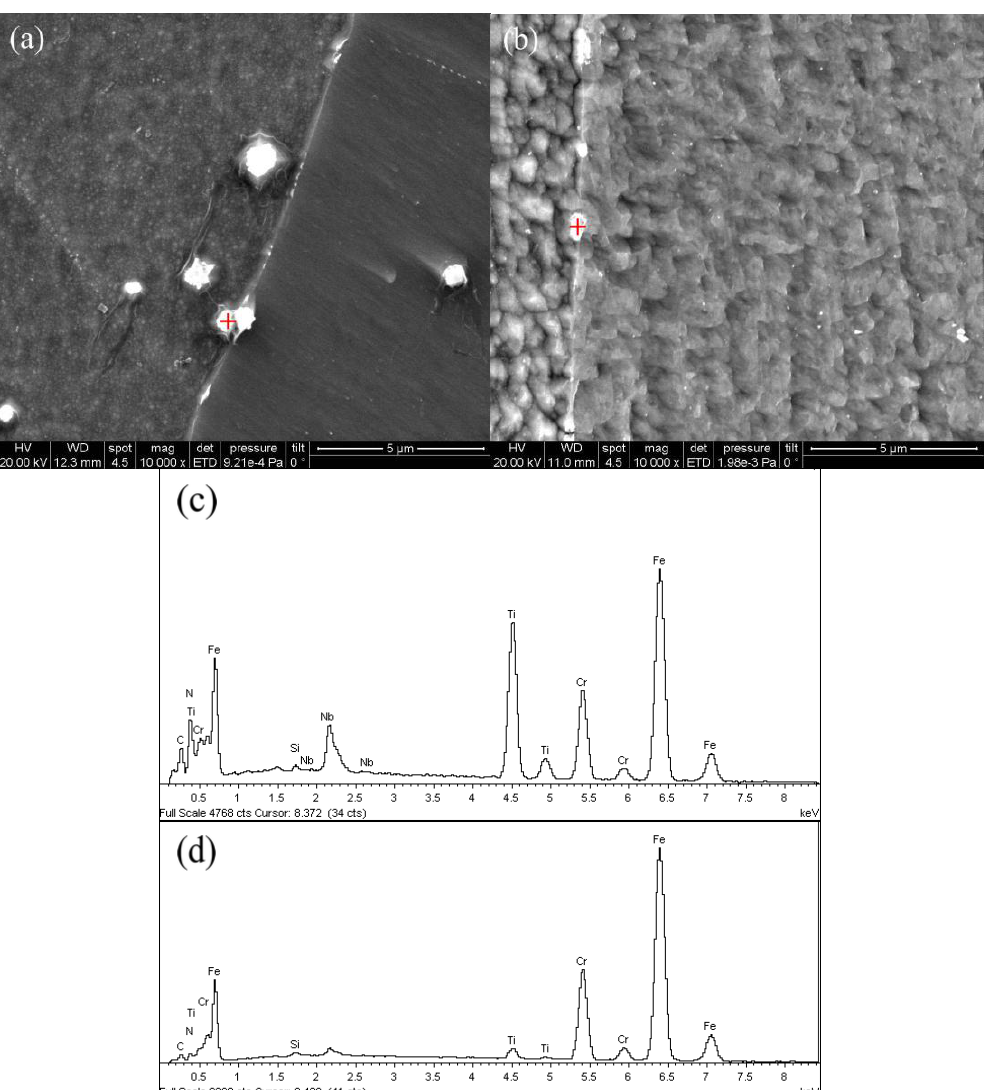
Figure 6. SEM images and EDS analyses of precipitations on the grain boundaries of ( a , c ) 441 and ( b , d ) 441Ce type materials, respectively.